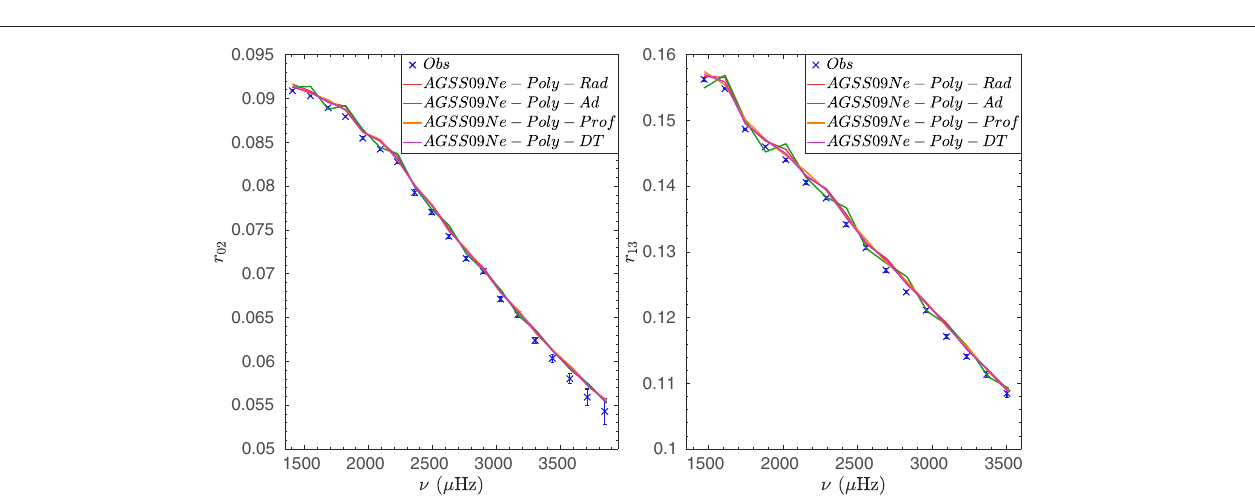
FIGURE 8 | Comparison between the observed frequency separation ratios and those of the solar models including modified opacity tables and additional macroscopic